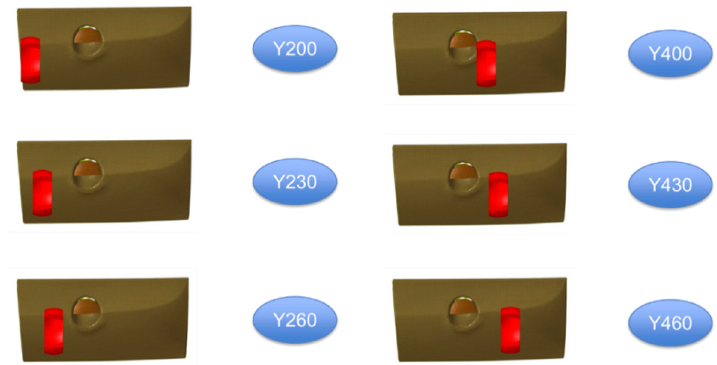
Figure 5. Simulated areas of contact between the knee and the glove box in the event of a frontal impact.